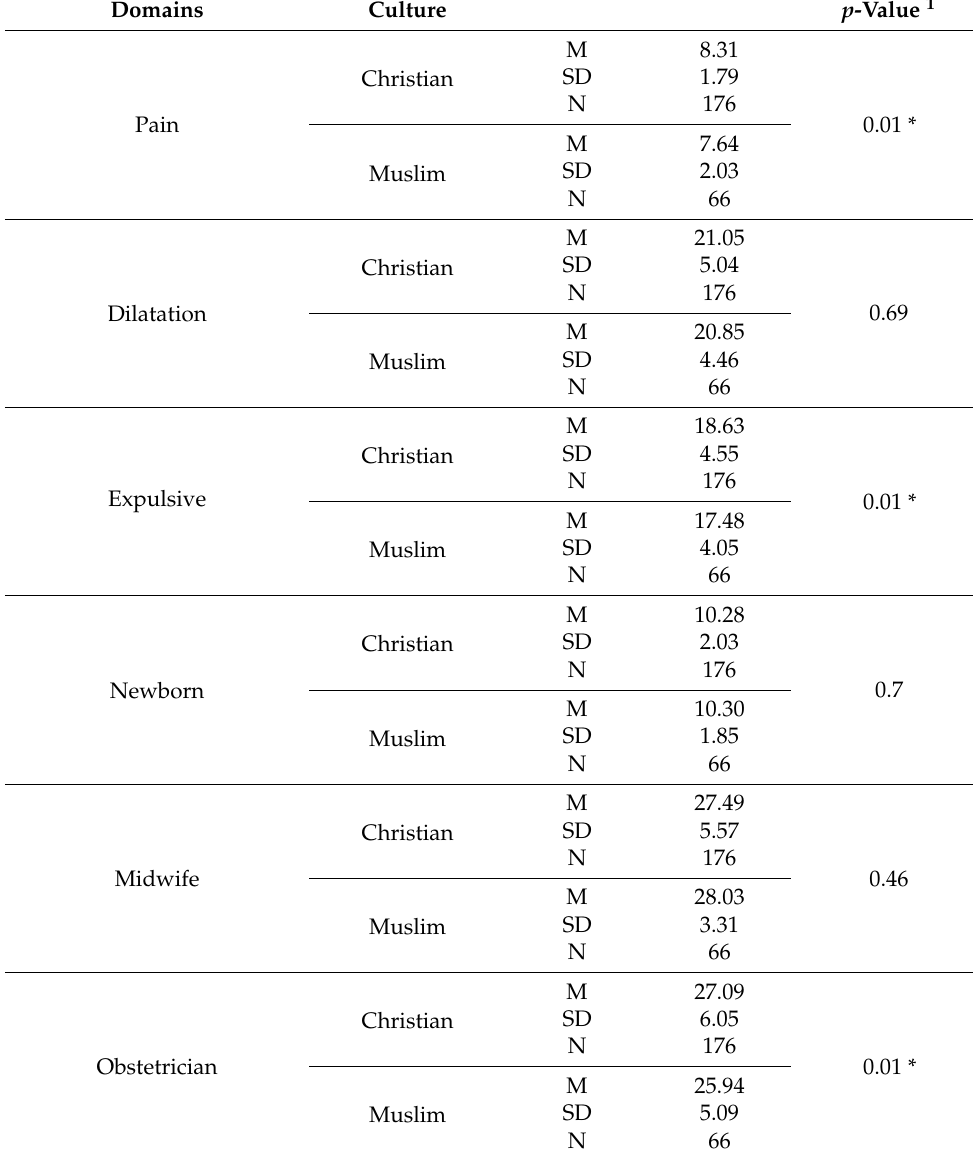
Table 3. Comparison between means according to the